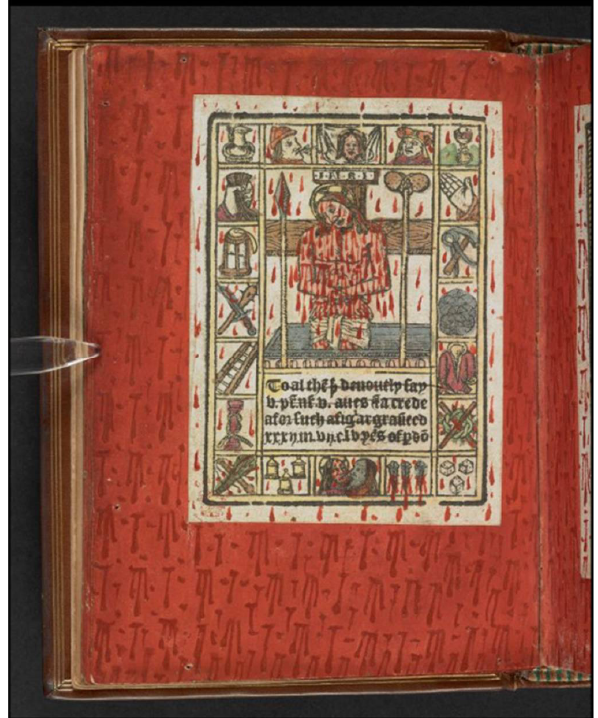
Figure 3. Three of the wounded pages have woodcuts pasted onto them. This first shows the Man of Sorrows surrounded by the Arma Christi. The entire woodcut is covered in blood stains as if the leaky body of Christ has flooded the page. MS Egerton 1821, fol. 8v. British Library, London.